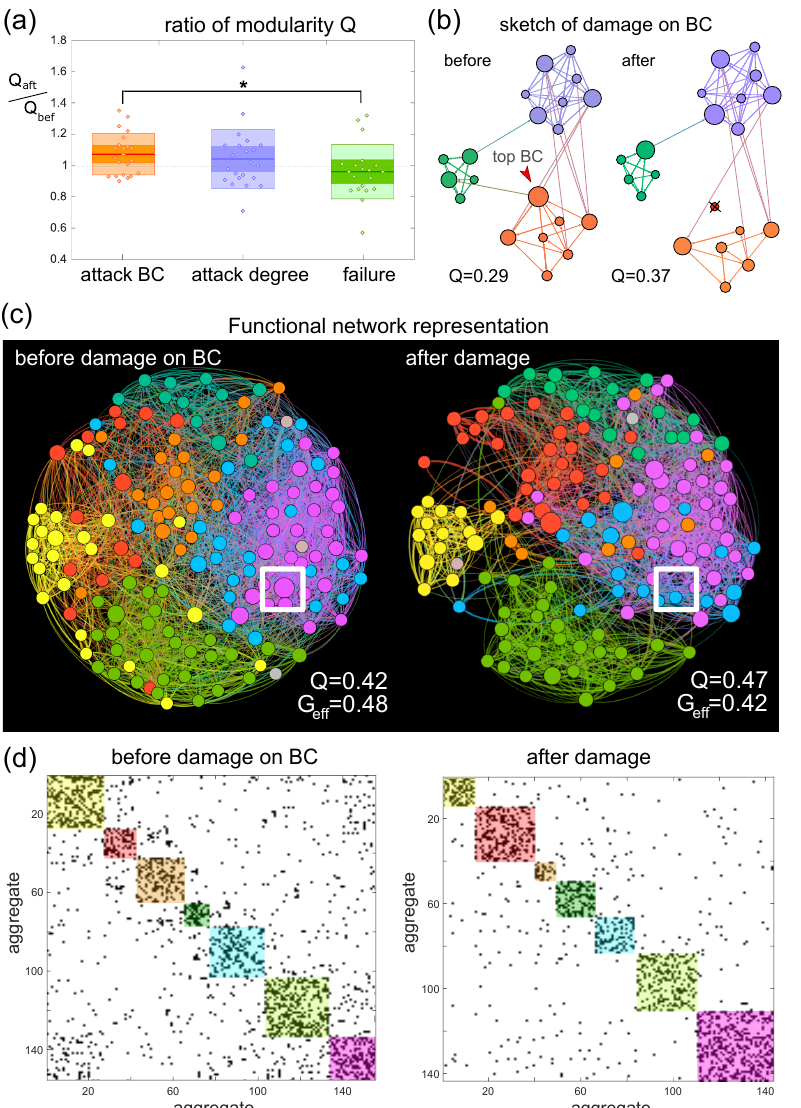
Figure 4. Alterations in modularity upon damage on aggregated cultures. ( a ) Box plot of the modularity ratio between after ( Q after ) and before ( Q before ) damage for the three different kinds of attack. Statistically significant differences are only observed between targeted attack on betweenness centrality BC and failure (* p = 0.0321, Student’s t -test). ( b ) Schematic representation of targeted attack on BC. In the sketch, nodes are colored according to the functional community they belong to, and the diameter of the nodes is proportional to their BC score. The top-scoring node is marked with an arrow and, upon deletion, the network becomes fragmented and the modularity Q grows. ( c ) Functional connectivity maps of a representative experiment before and after a targeted attack on BC. The deleted node is marked by a white square. The network becomes overall more segregated, with an increase in Q and a decrease in G eff . The nodes in the maps are color-coded according to the functional community they belong to. ( d ) Corresponding connectivity matrices before and after attack. Black dots are effective connections and color boxes are functional communities. The increase in network fragmentation is depicted here by a reduction in the density of effective connections between